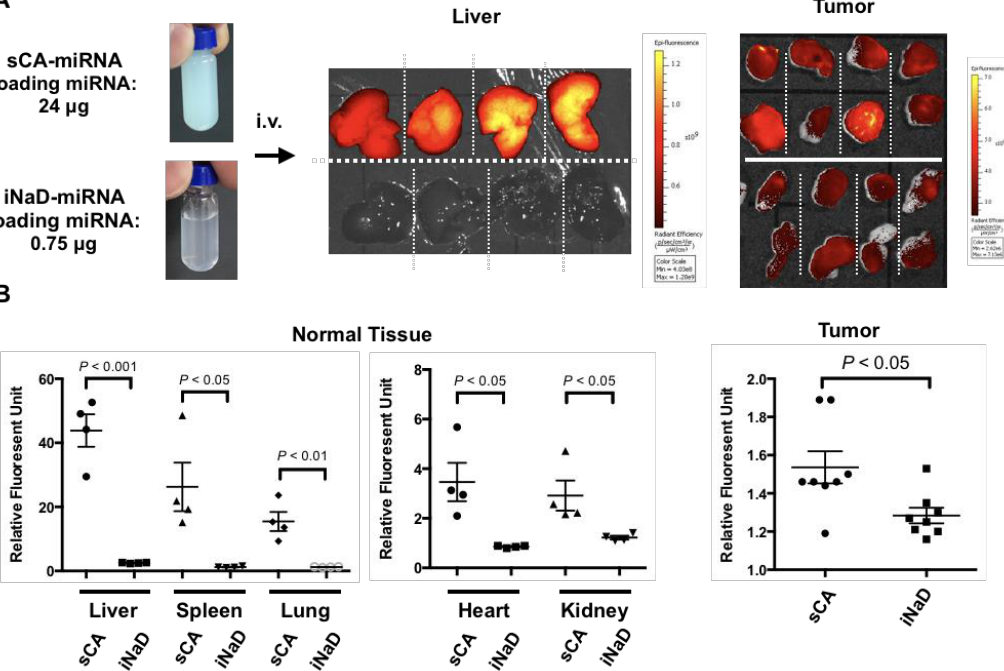
Figure 5. Bio-distribution of iNaD-miRNA. We defined the processed D-miRNA as the inorganic nanoparticle device (iNaD) system. ( A ) sCA- miRNA (miRNA loading: 24 μg) or iNaD - miRNA (miRNA loading: 0.75 μg) was intravenously injected into HT29 tumor-bearing mice (tumors = 8 from 4 mice). Ex vivo IVIS imaging of the tumor and liver was per- formed 1 h after the injection. ( B ) Quantitative analyses of tumor and normal tissues (liver, spleen, lung, heart, kidney). Data represent mean ± SEM (n = 4 normal tissues from 4 mice, n = 8 tumors from 4 mice). P -values were obtained using the two-tailed t test.